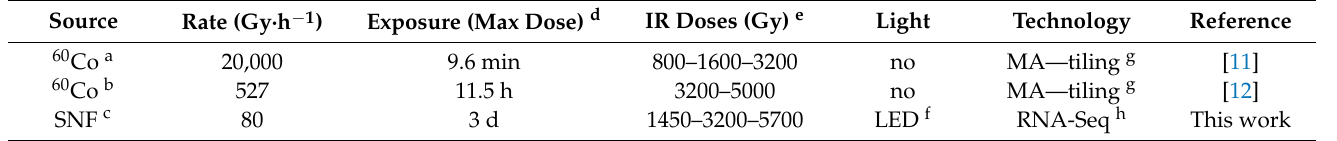
Table 1. Transcriptomic studies on IR-exposed L. indica PCC